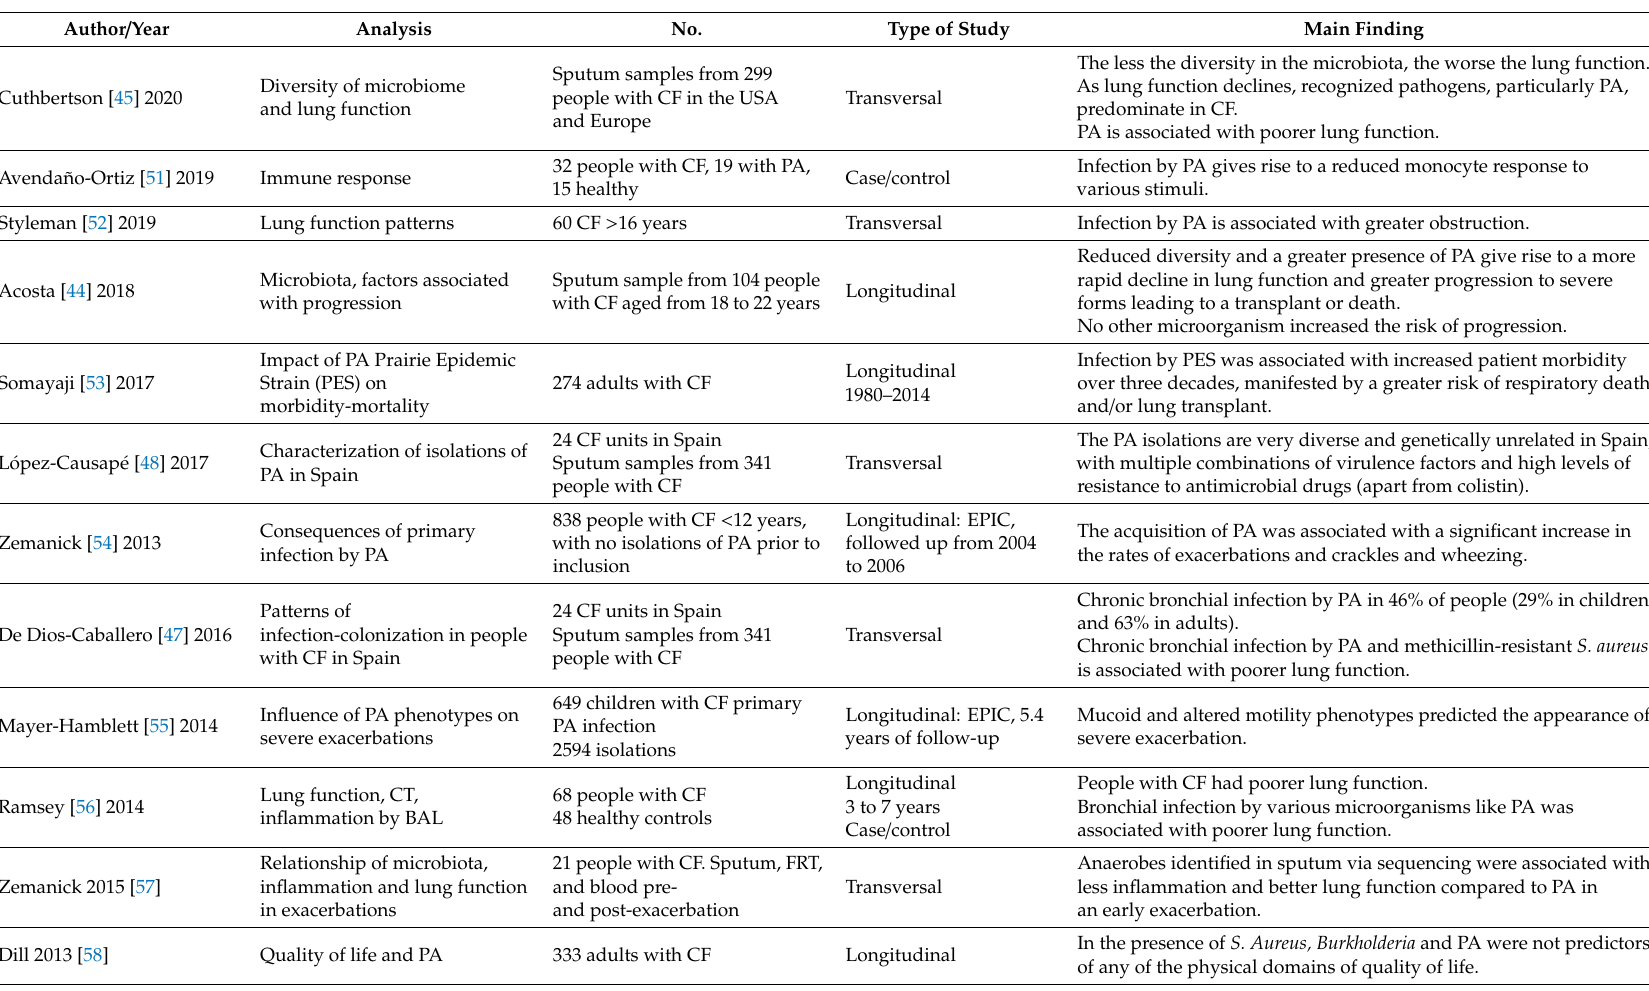
Table 2. Studies that have analyzed the various consequences of infection by Pseudomonas aeruginosa in people with cystic